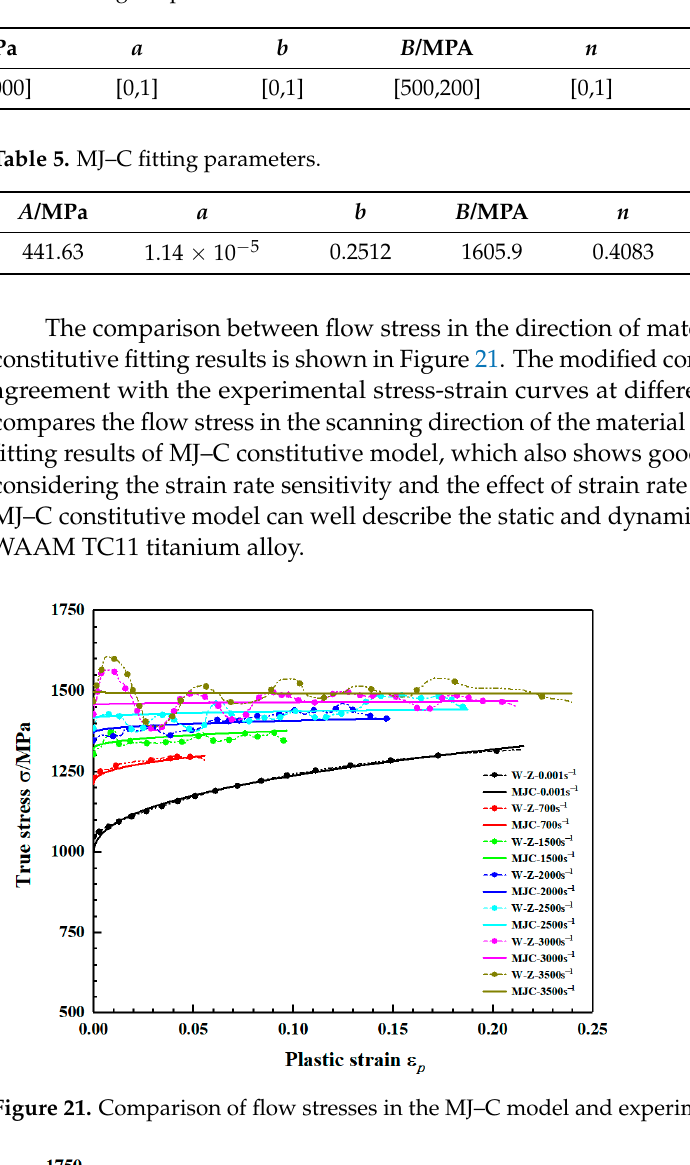
Table 4. Range of parameter values.